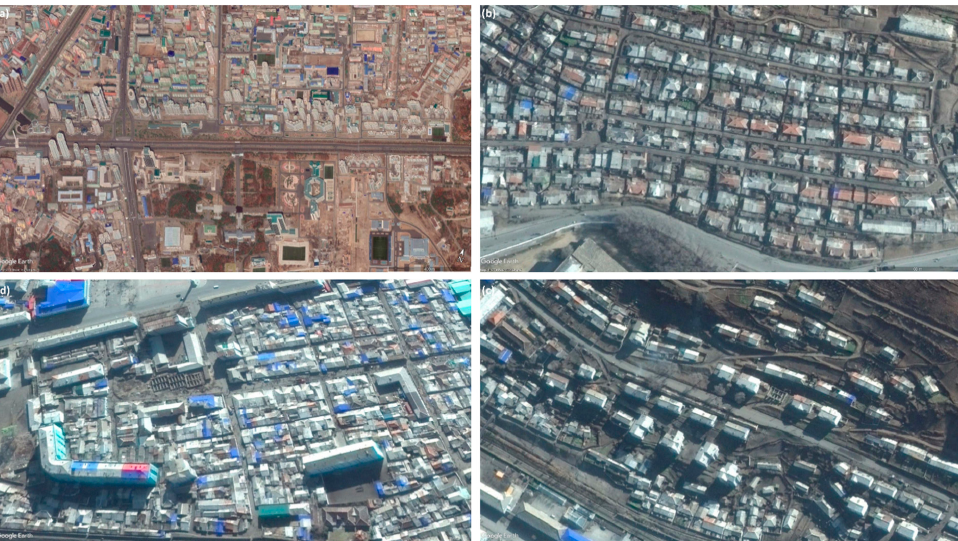
Figure 6. Different types of housing and their morphological features. ( a ) Condominium or residential block buildings; ( b ) detached houses; ( c ) (semi-)detached houses; ( d ) showing different forms of housing shapes (e.g., linear, curved, rectangular patterns and different colors of roofs etc.) (Image sources: Google Earth, date of access: 16 October 2019).